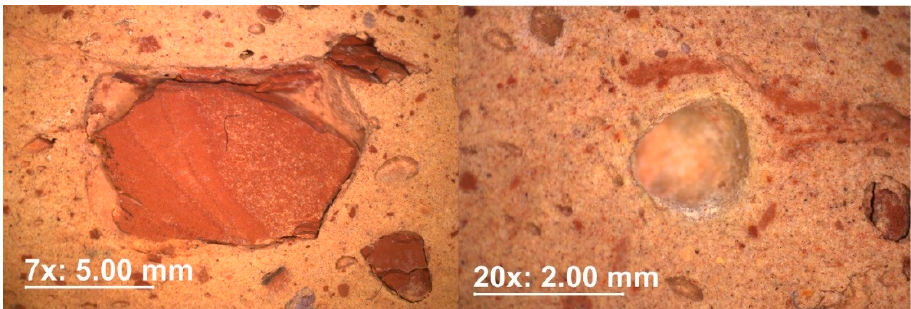
Figure 2. Microscopic photos of a brick sample from the tested wall. clay origin. The pores visible in the figure on the right are approximately 0.3 mm in size and one pores approximately 1.5 mm in diameter. The pore area covers 11% of the field of view. The analysis of the structure of bricks before and after firing can be found in [25].